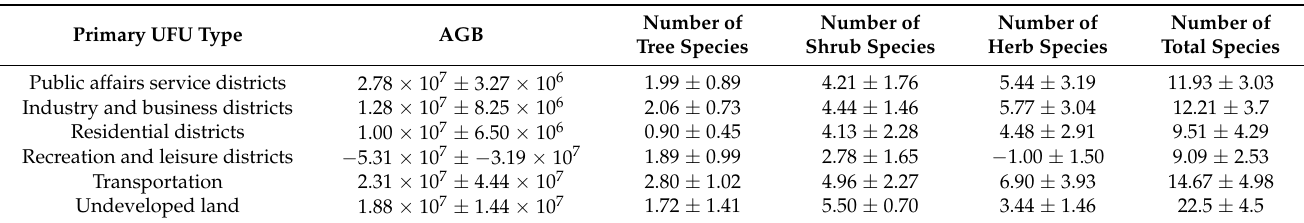
Table 2. Mean and standard deviation changes of AGB and the number of total, tree, shrub and herb species in primary UFU in Haikou from 2015 to